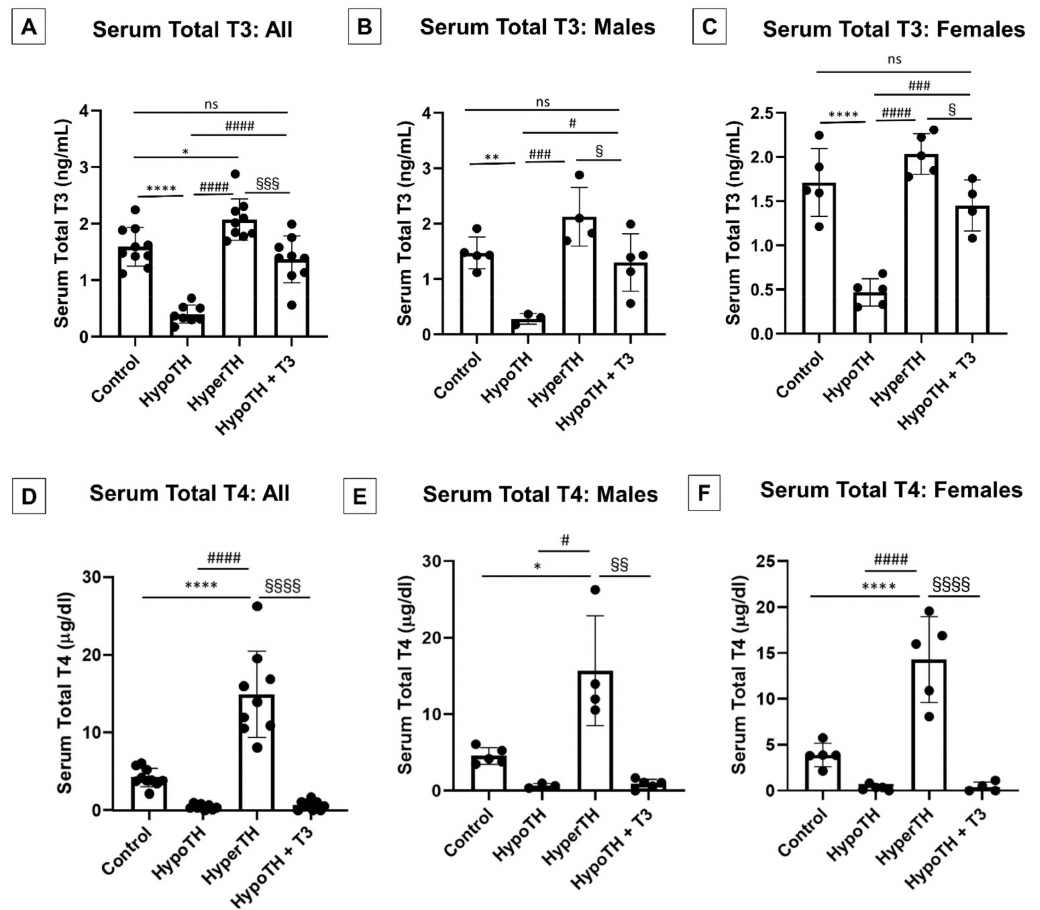
Figure 1. Serum levels under altered thyroid hormonal states: Serum levels of ( A – C ) total T3 and ( D – F ) total T4 showed reductions in HypoTH, increases in HyperTH, restored T3 levels, T4 feedback inhibition and similar trends in both the sexes. ( A , D ) All mice; ( B , E ) Male mice; ( C , F ) Female mice; All values are means ± standard deviation; n = 8–10 per group. TH: thyroid hormone; HyperTH: Hyperthyroidism; HypoTH: Hypothyroidism; T4: Thyroxine; T3: